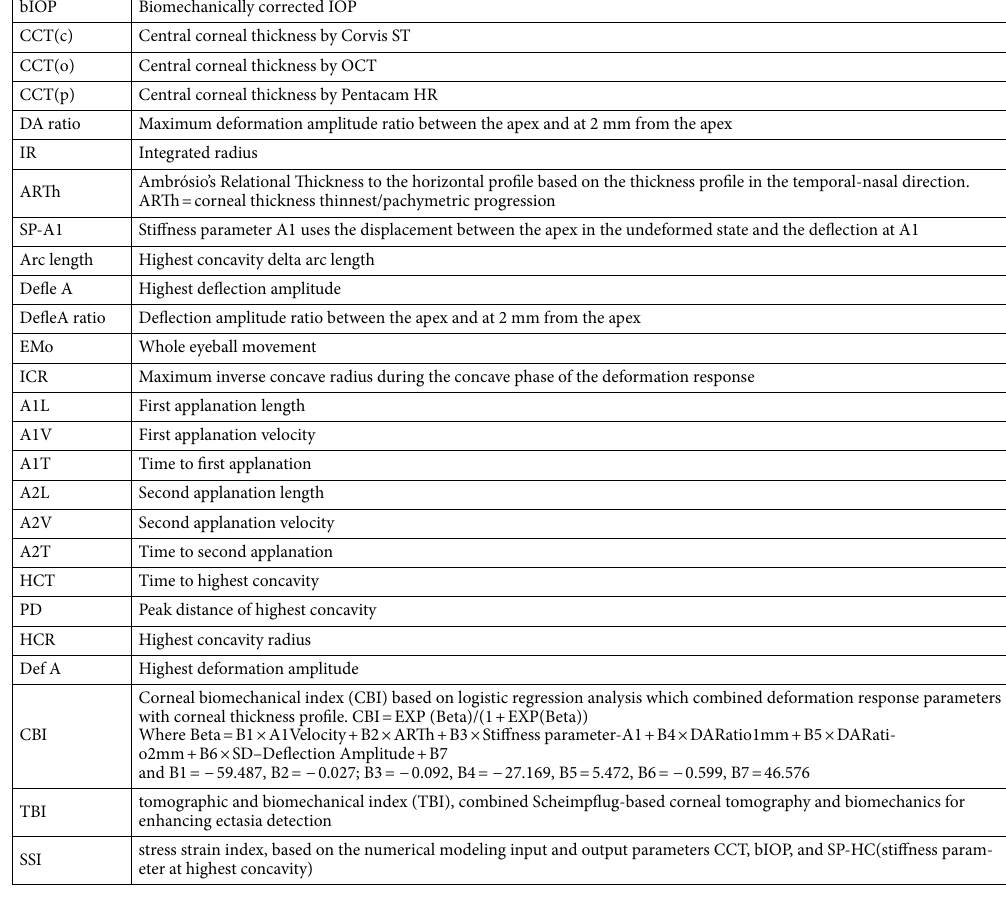
Table 4. A brief description of Corvis ST